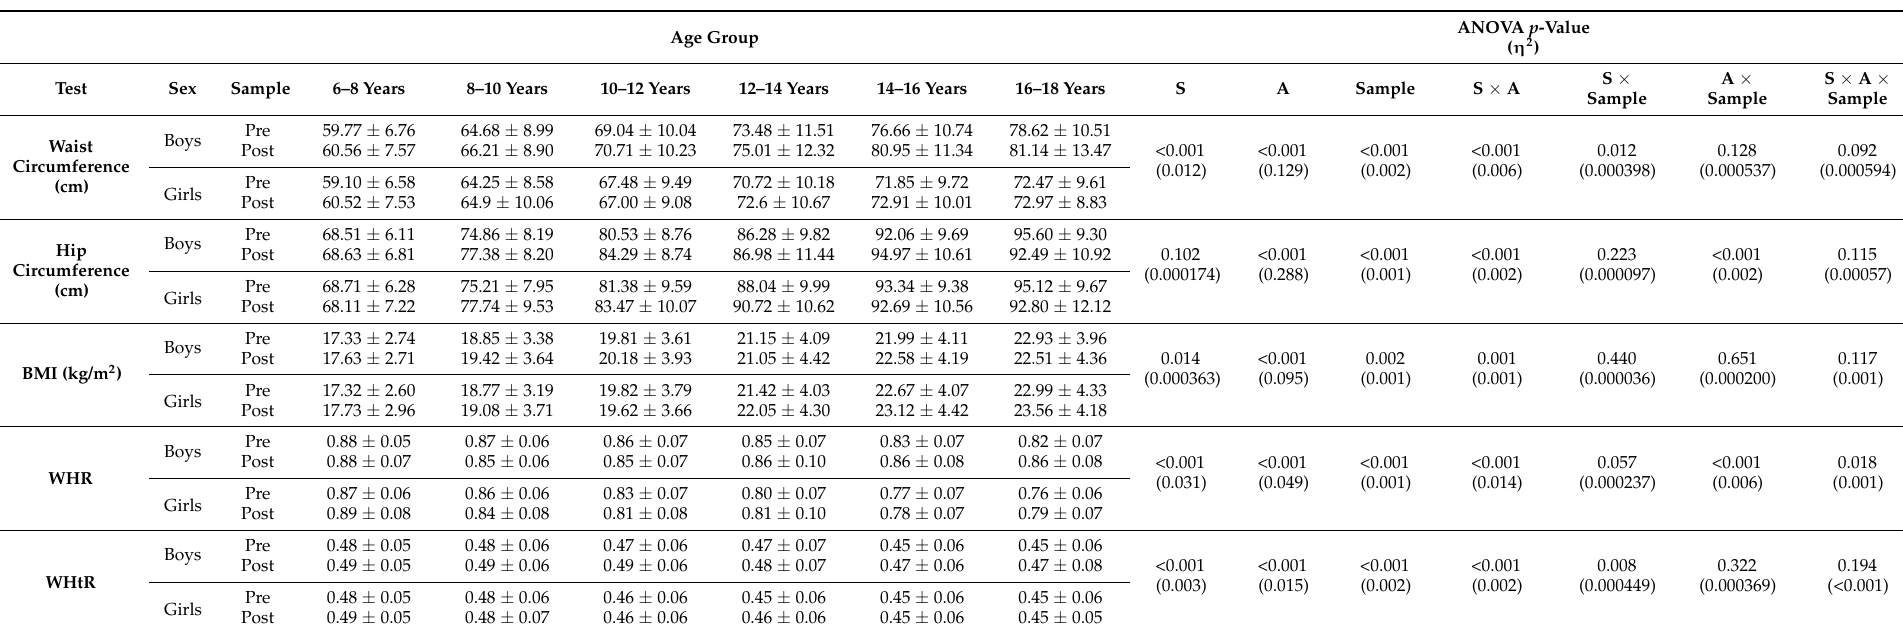
Table 1. Body composition values before and during